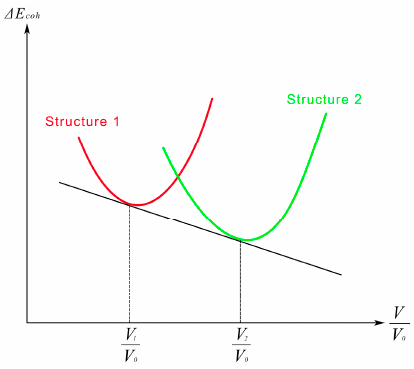
Figure 8. Principle of stress induced transition between two different phases.